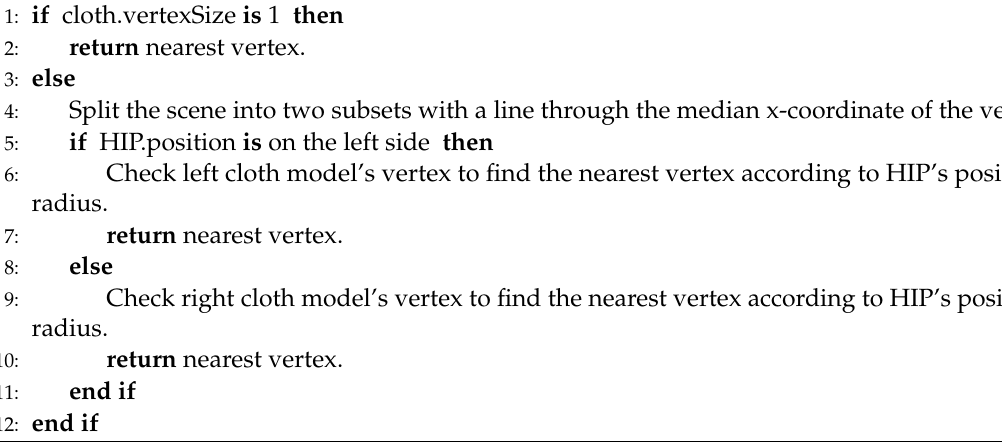
Algorithm 2 K-d-tree algorithm.